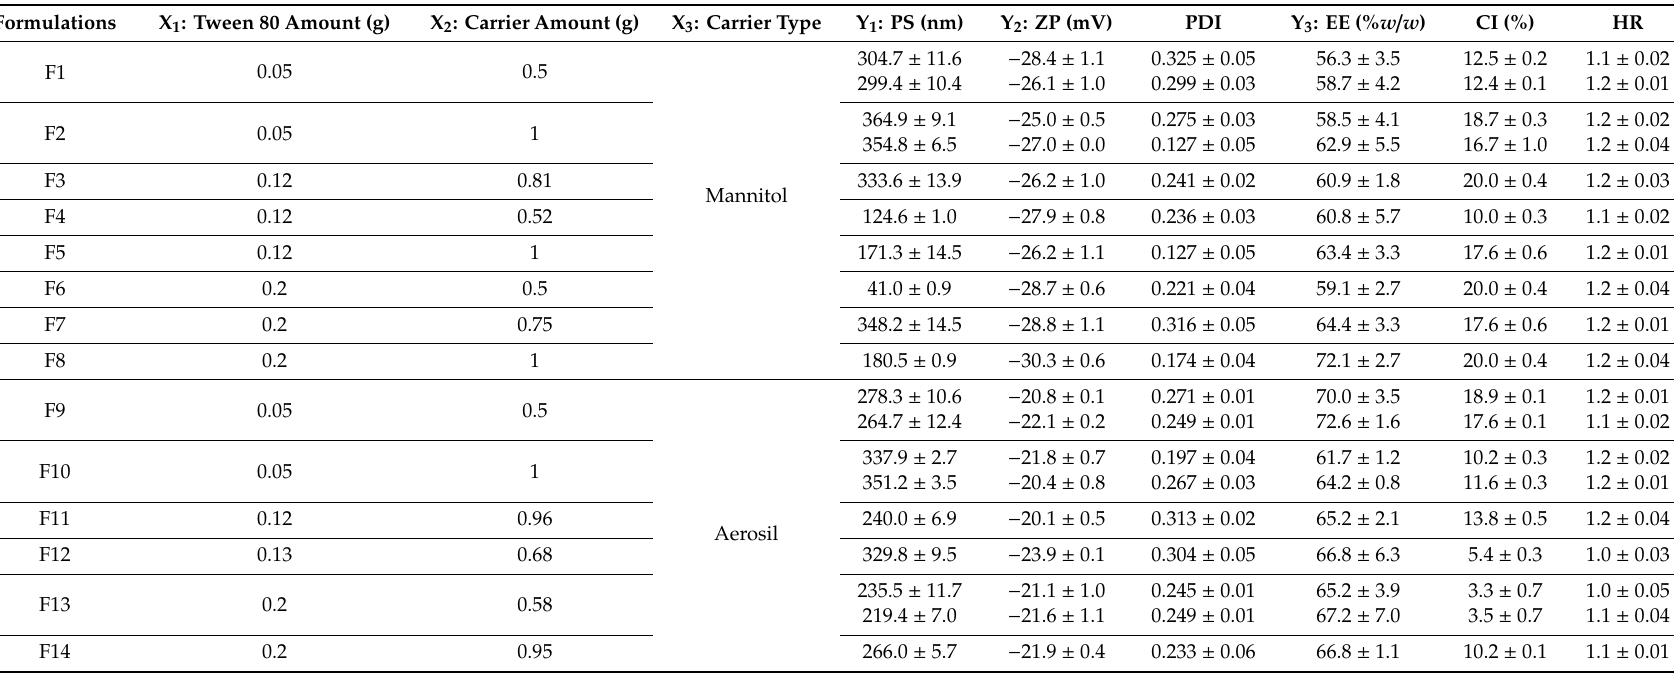
Table 1. Experimental runs, independent variables, and measured responses of the D-optimal experimental design for the IFN formulations.